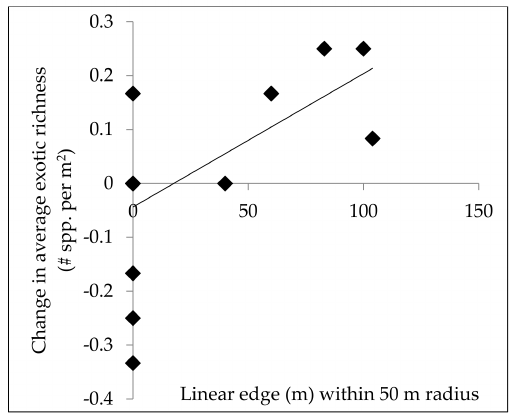
Figure A3. Linear regression of the change in average exotic plant richness (number of species per m 2 ) from pre- to post-disturbance plotted against the amount of linear edge (m) within a 50 m radius of each disturbed plot. y = 0.002 x – 0.04, p -value = 0.011, R 2 =